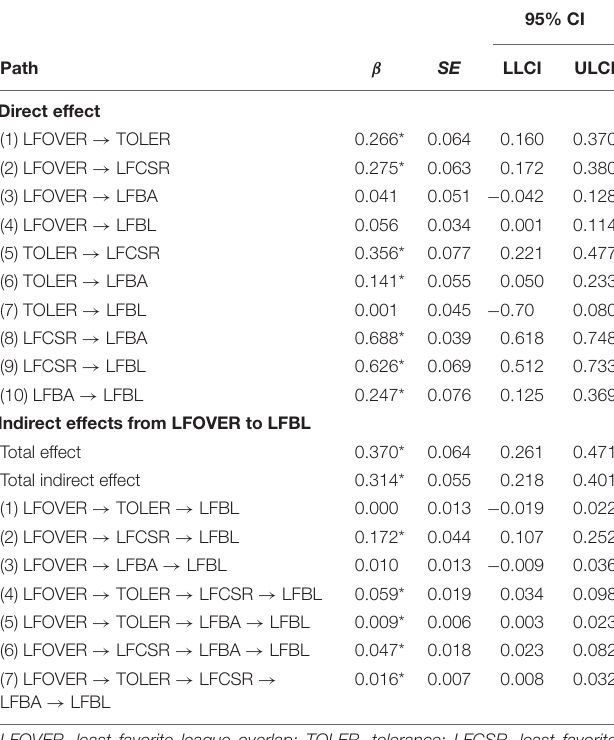
TABLE 6 | Model estimates for least favorite